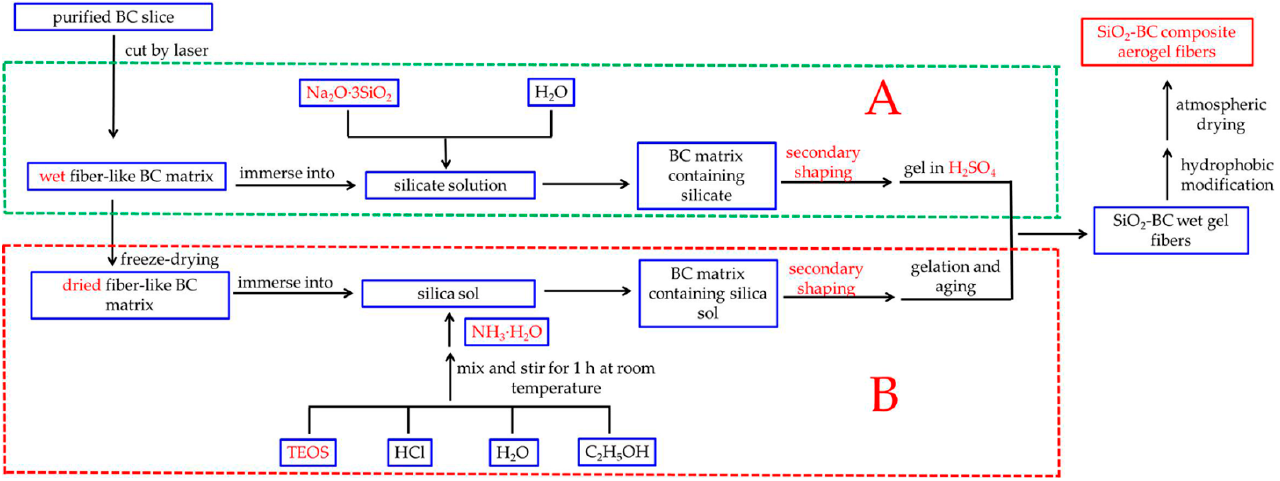
Figure 1. Flowchart illustrating the overall processes used in this work ( A ) and previous work ( B